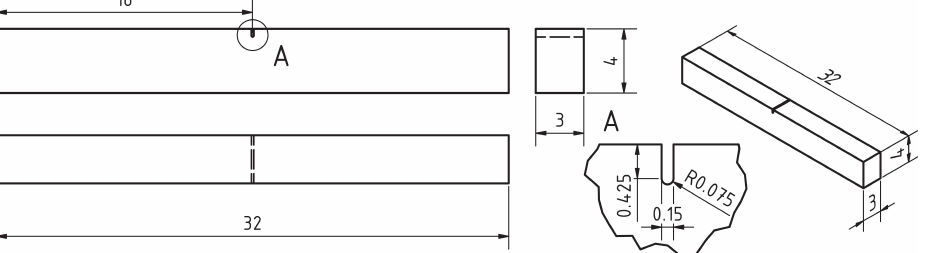
Figure 2. The simple geometry and dimensions (in mm) of the universal specimen used for multiple tests. The notch is present in specimens designated for fracture toughness and fatigue crack growth rate tests, while the stress–strain test specimens are